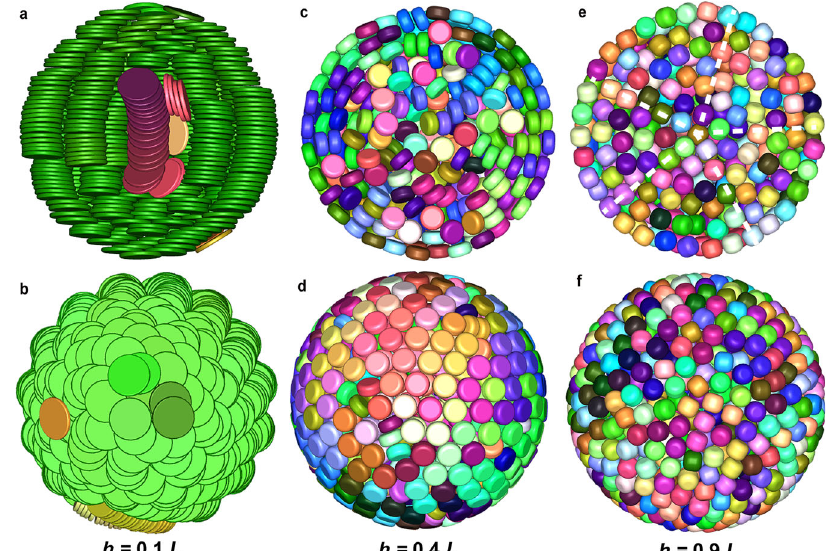
Fig. 4 | Structural transition from columnar structure to icosahedron. Fully compressed con fi gurations as obtained from computer simulations with 1000 particles in spherical con fi nement with different aspect ratio h / L . a , b 0.1, c , d 0.4, e , f 0.9,respectively.Thetopandbottomcolumnofeachpairshowsacut-through and a surface view, respectively. The fi ve-fold symmetry of a Mackay icosahedral cluster is readily visible as denoted by the white dashed lines in panel e . Note that